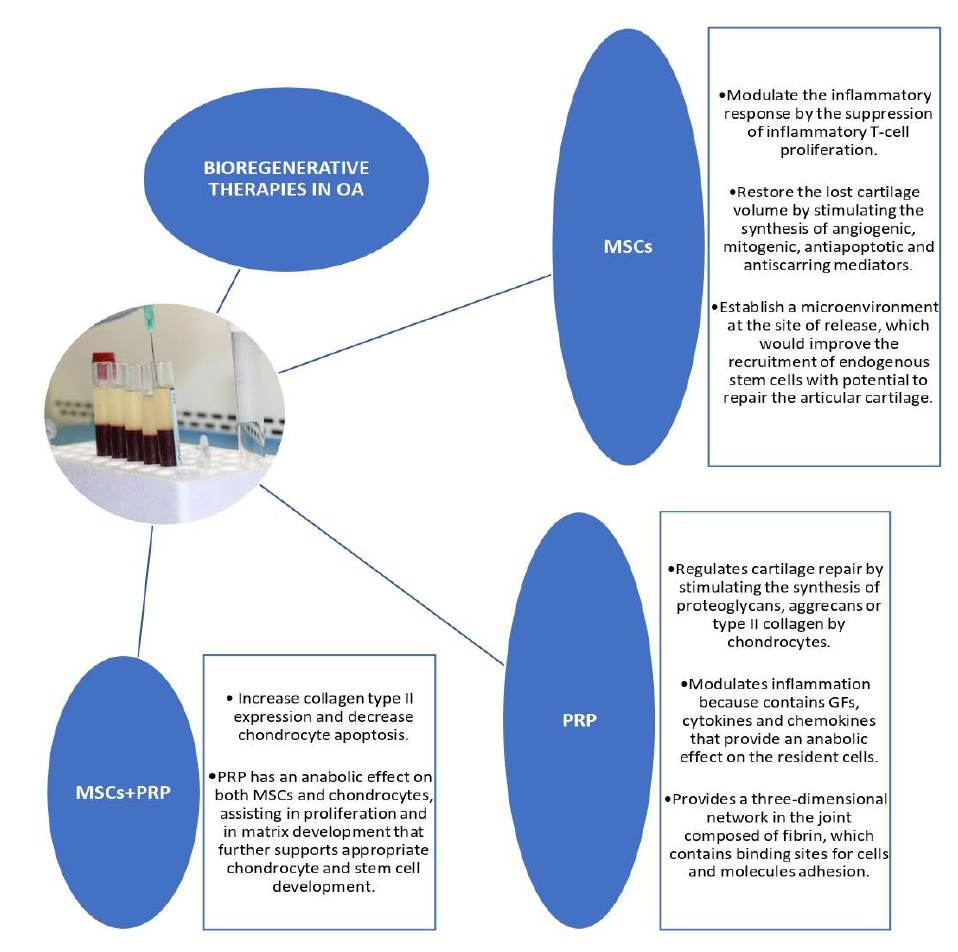
Figure 1. Graphical abstract showing the role of MSCs and PRP in OA. OA: osteoarthritis; MSCs: mesenchymal stem cells; PRP: platelet-rich plasma; GFs: growth factors.